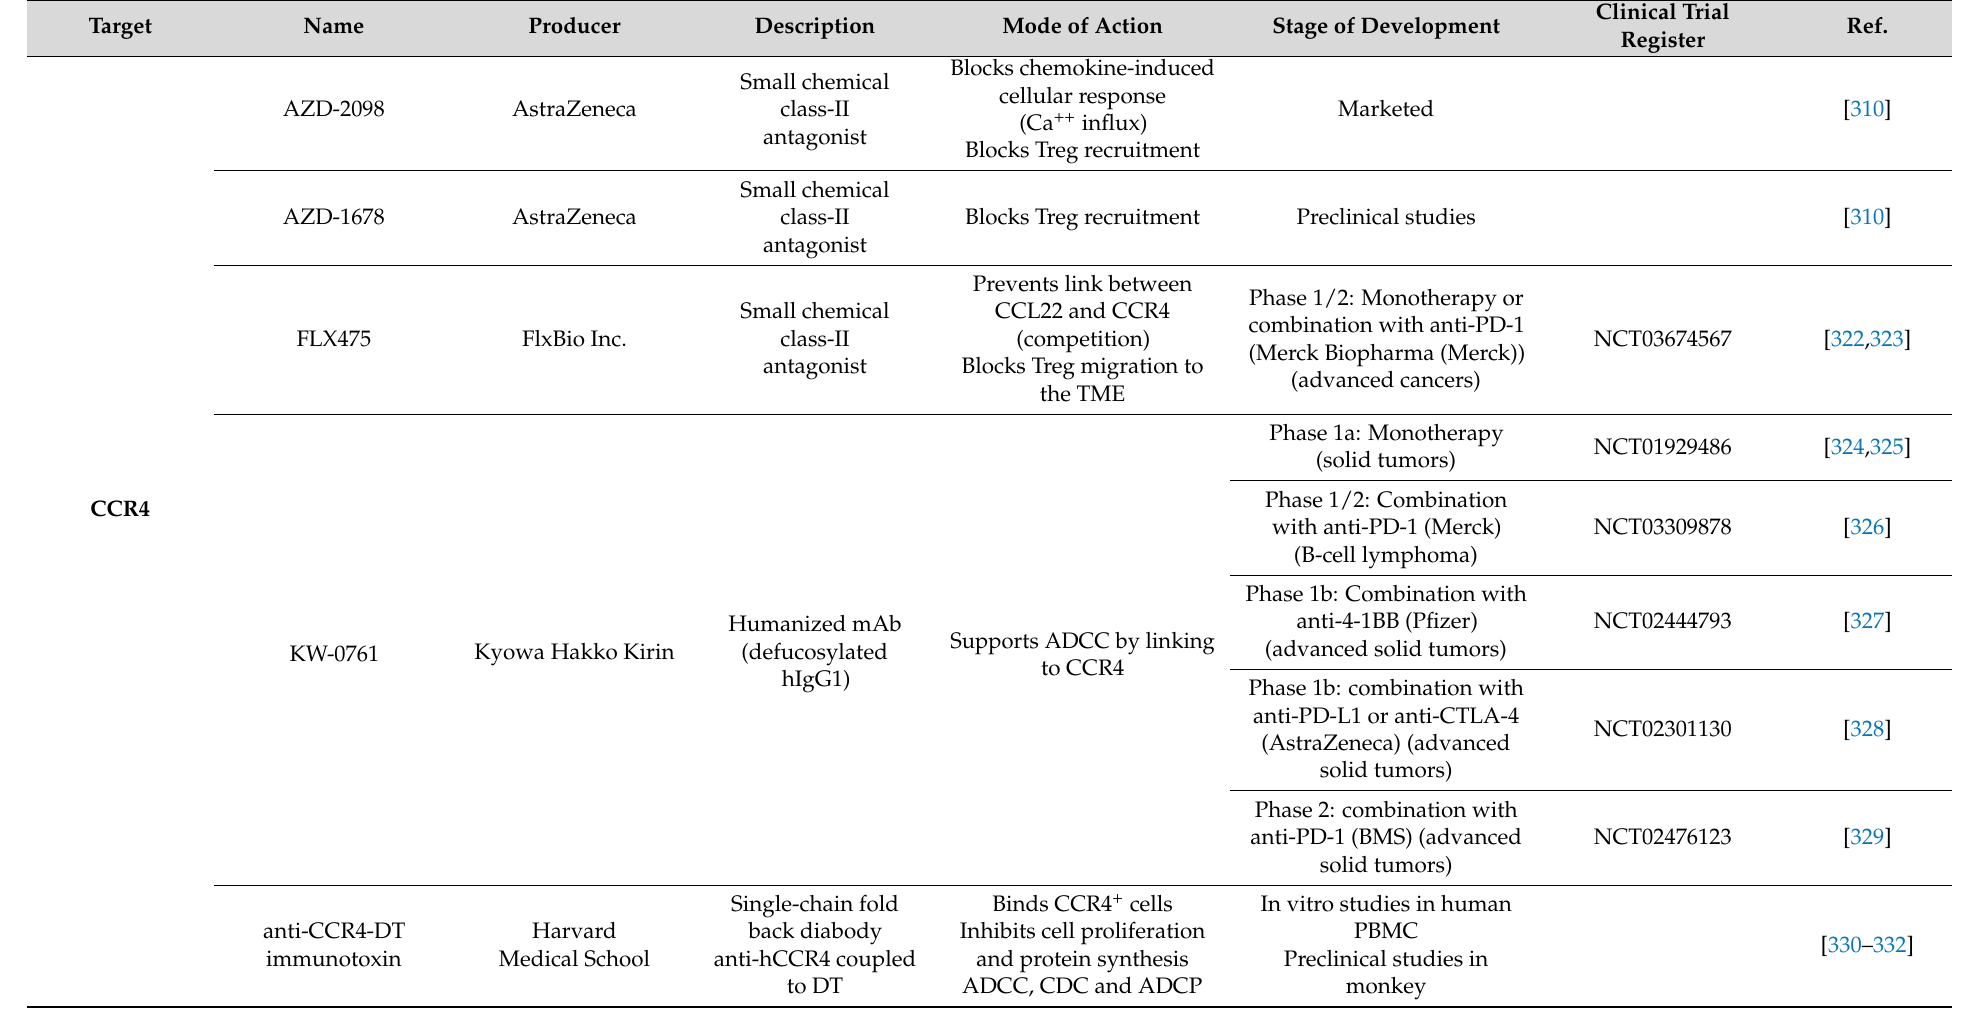
Table 1. Different therapeutic strategies developed to antagonize regulatory T-cell (Treg0 immunosuppression in